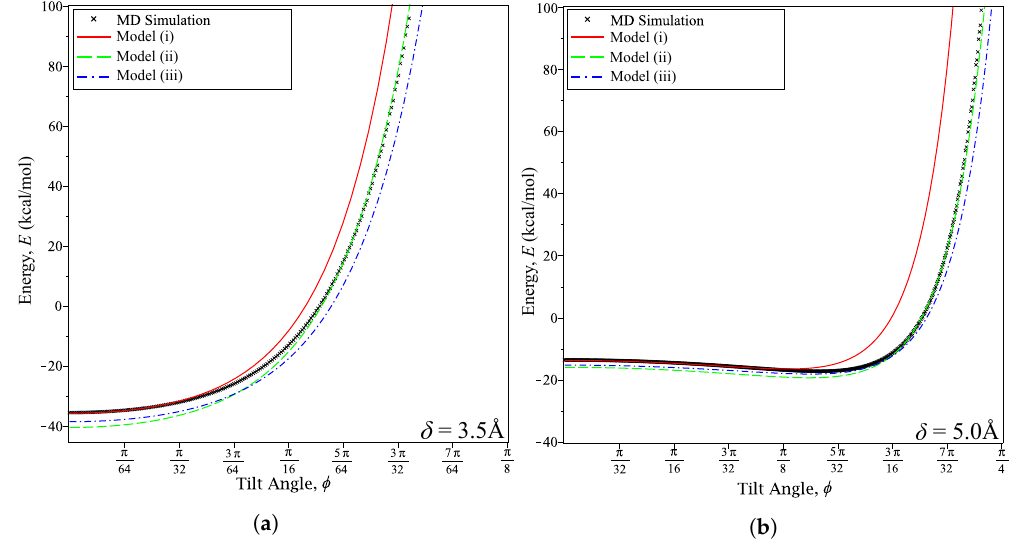
Figure 4. Energy curves at various fixed δ for varying φ : ( a ) δ = 3.5Å; and ( b ) δ =